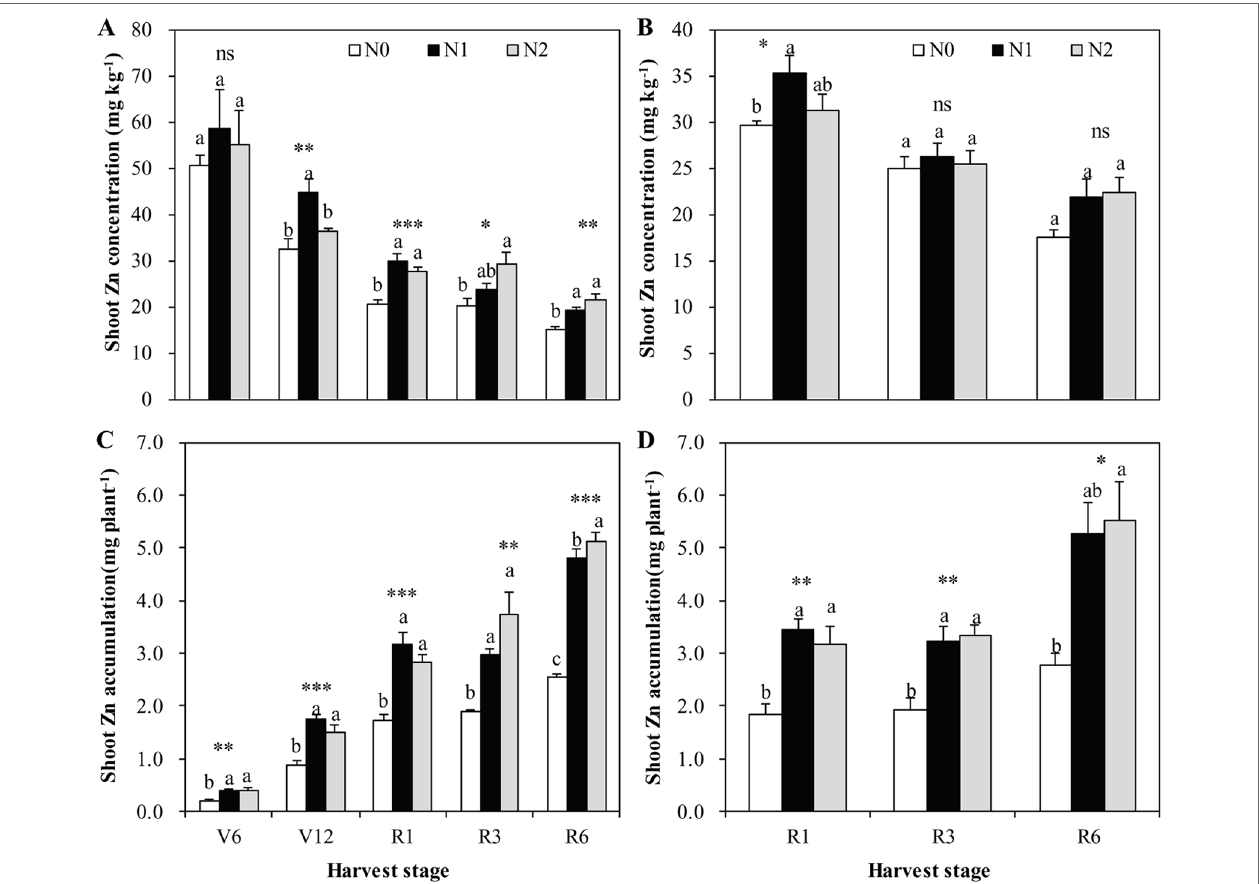
FIGURE 3 | The shoot Zn concentration and accumulation of summer maize at V6, V12, R1, R3, and R6 stages as affected by N application rates in 2009 (A , C) and 2010 (B , D) , respectively, in the field. The bars represent the standard error of the mean ( n = 4 in 2009 and n = 3 in 2010). For each stage, bars with same lowercase letters are not significantly different in different N treatments (P < 0.05). ns indicates no significant difference. *, **, and *** indicate significant difference at P < 0.05, < 0.01, and < 0.001,